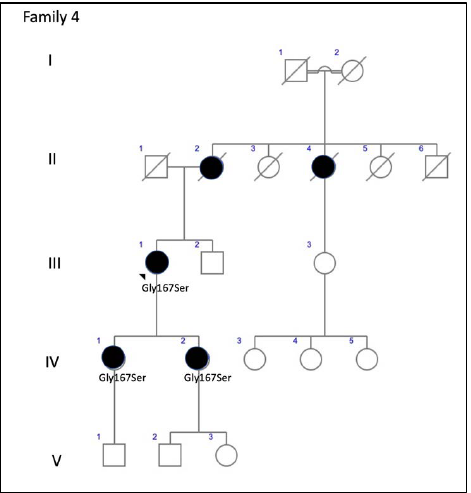
Figure 9. The family 4 pedigree shows a dominant inheritance pattern.